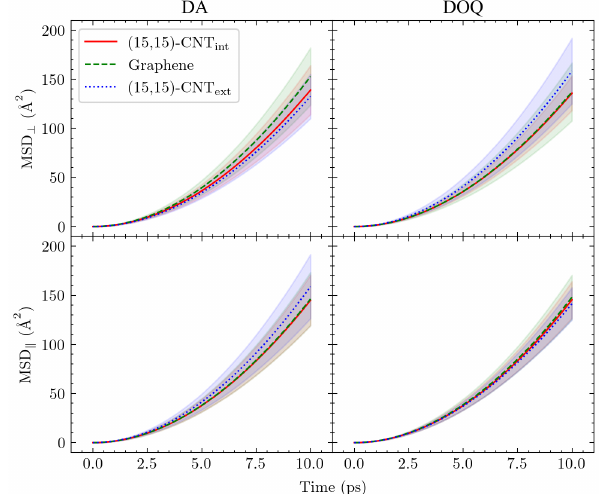
Figure 6. MSDs of DA and DOQ on differently curved carbon:vacuum surfaces. The top and bottom panels show the MSDs as a function of time along two surface directions, (cid:107) and ⊥ , on graphene and on the interior and exterior of the ( 15,15 ) -CNT. The left and right panels display the results for adsorbates DA and DOQ, respectively. The lines show the average MSD values, while the shaded regions show the standard deviation in that value across ten trials, with red shading for ( 15,15 ) -CNT ( 15,15 ) -CNT ext int , green shading for flat graphene, and blue shading for